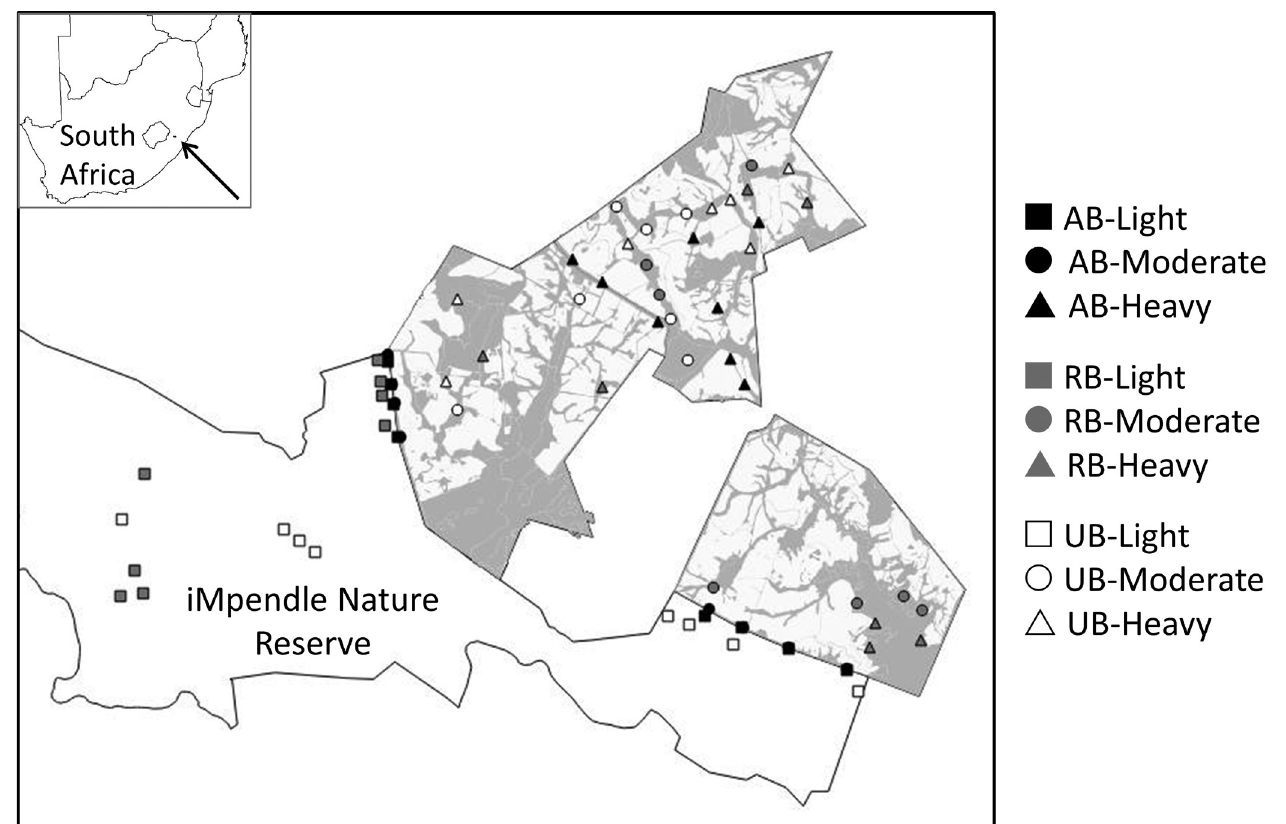
Fig. 1. Map of study sites in the KwaZulu-Natal Midlands. Abbreviations for grazing intensity: light in iMpendle Nature Reserve (square symbols), and moderate (circular symbols) or heavy (triangular symbols) in the ecological network. Abbreviations for fire regime: annual burning (AB, solid black symbols), grasslands with longer fire rotation that were recently-burned (RB, solid grey symbols) i.e. burned < 12 months prior to sampling and unburned (UB, open symbols) i.e. burned >12 months prior to Table 1. Description of the grazing and fire regime in each group of sites. Abbreviations for grazing intensity: light in the protected area (PA), and moderate or heavy in the ecological network. Ab- breviations for fire regime: annual burning, grasslands with longer fire rotation that were recently-burned (i.e. burned < 12 months prior to sampling) and unburned (i.e. burned >12 months prior to sampling).